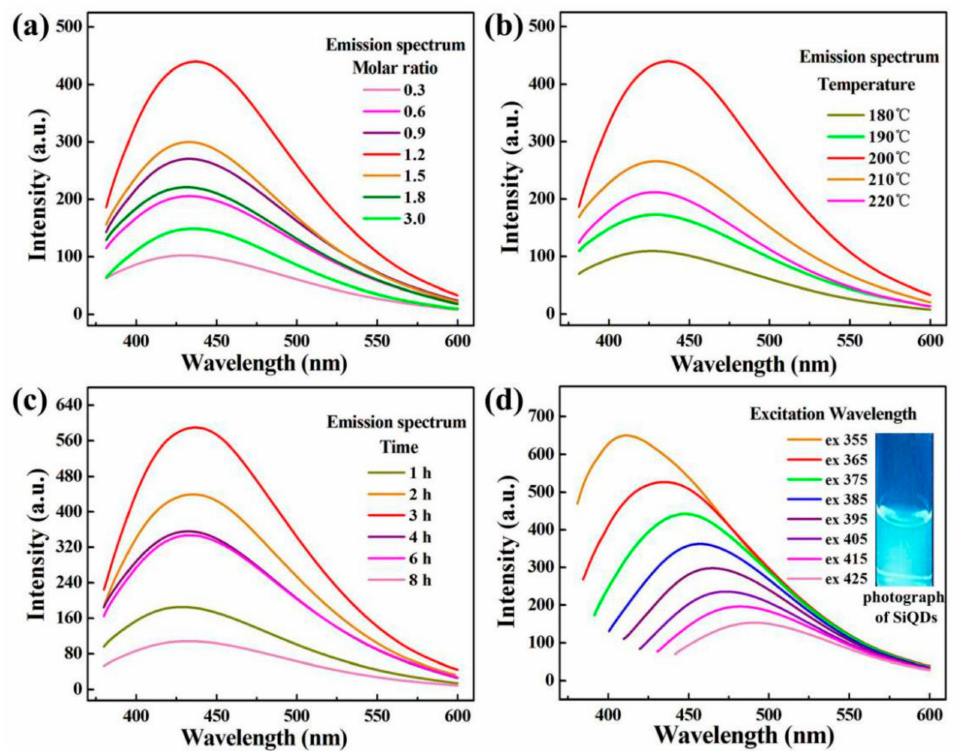
Figure 1. Photoluminescence (PL) spectra of silicon quantum dots (SiQDs). ( a ) Di ff erent molar ratios; ( b ) di ff erent temperatures; ( c ) di ff erent reaction times ( λ ex = 365 nm) and ( d ) di ff erent excitation wavelengths ( λ ex = 355–425 nm). Inset in ( d ) is digital photographs of SiQDs under 365 nm UV lamp irradiations.